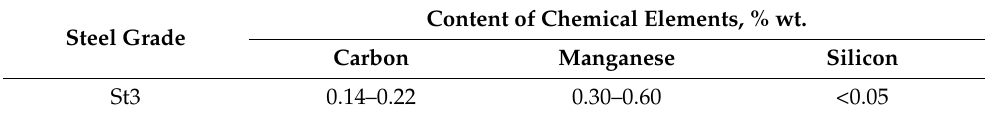
Table 1. Chemical composition of steel. Steel Grade